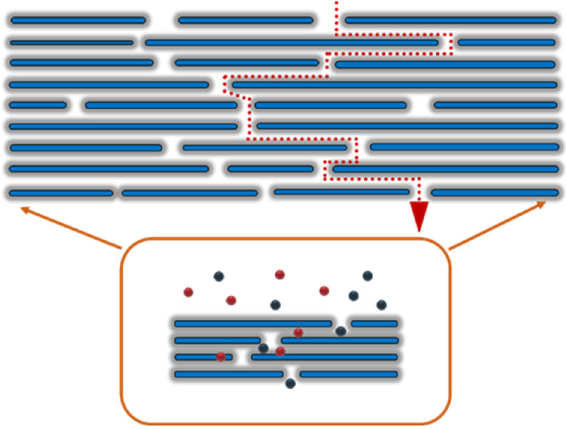
Figure 7. Schematic diagram of adsorption of heavy metal ions by MnO 2 /MXene composite film [27].